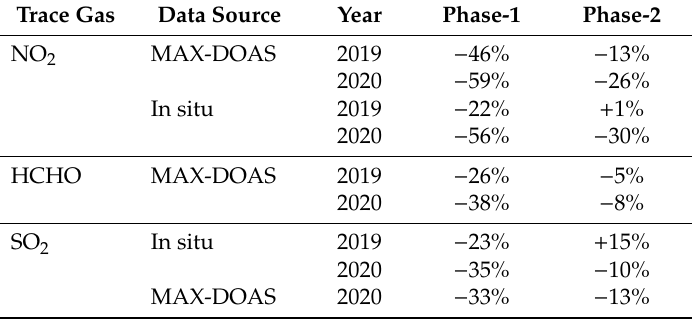
Table 2. Shows a comparison of mean concentration changes during di ff erent phases in 2019 and 2020. ( + shows an increase in the concentration and − shows a reduction in the